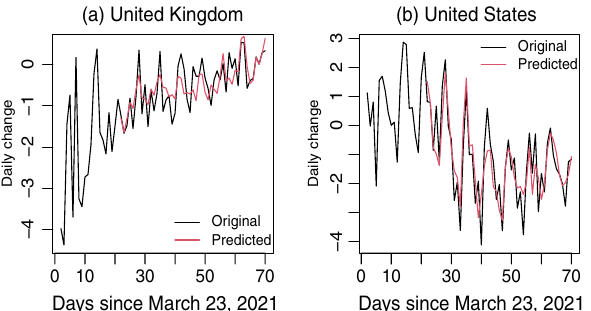
Figure 2. Original and predicted △ HOSP since March 23, 2021 in ( a ) United Kingdom and ( b ) United States.